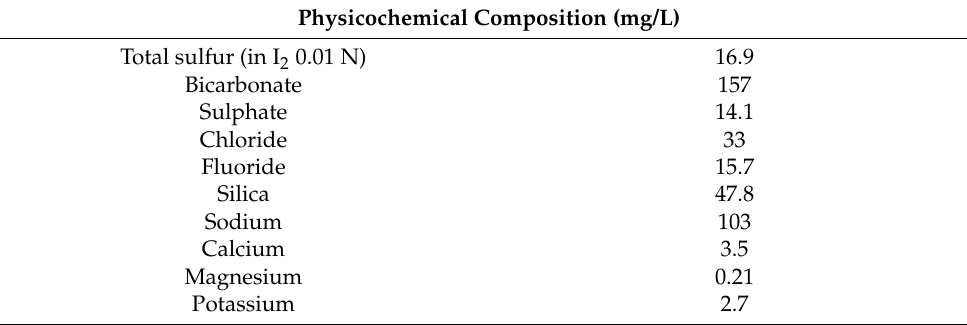
Table 1. Cr ó thermal water composition. Adapted from